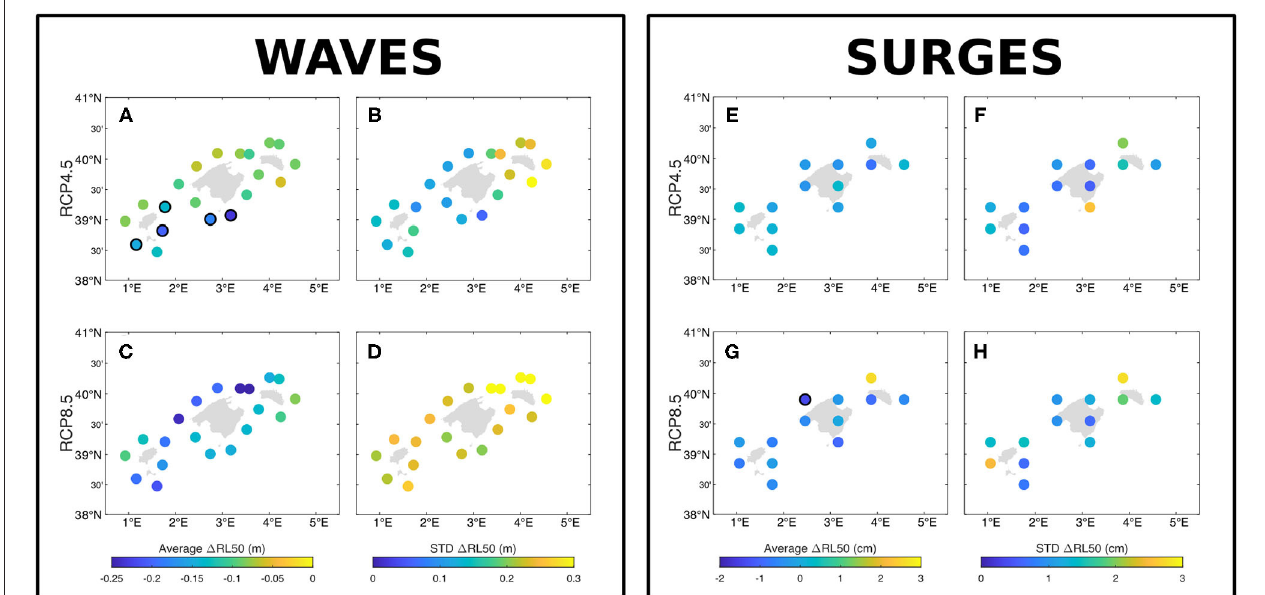
FIGURE 3 | Multi-model mean differences in 50-year return levels between projections (2070–2099) and historical (1970–1999) runs of Hs are shown in panels (A) (RCP4.5) and (C) (RCP8.5), while multi-model standard deviations of the differences are shown in panels (B) (RCP4.5) and (D) (RCP8.5). The same information is provided for SS in panels (E) , (F) , (G) , and (H) . Grid points circled black indicate that projected changes are greater than the standard deviation between